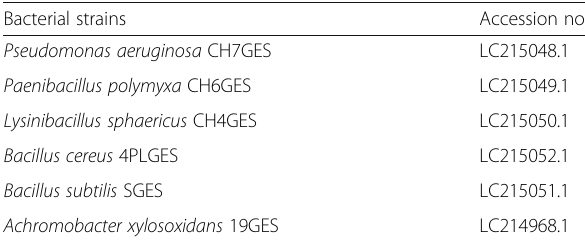
Table 1 The bacterial strains and their accession numbers in Genbank data base Bacterial strains